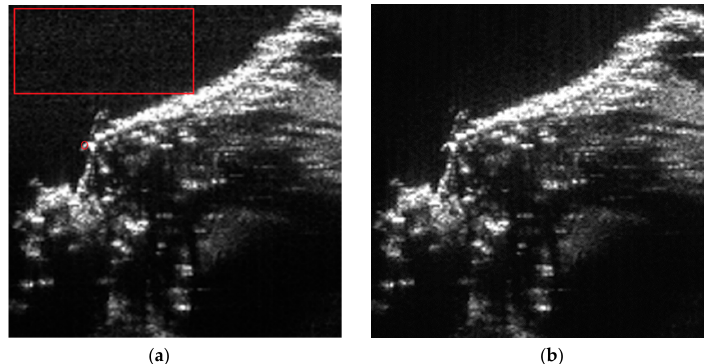
Figure 13. Real data processing results: ( a ) using traditional range migration algorithm (RMA) and ( b ) using proposed RMA.